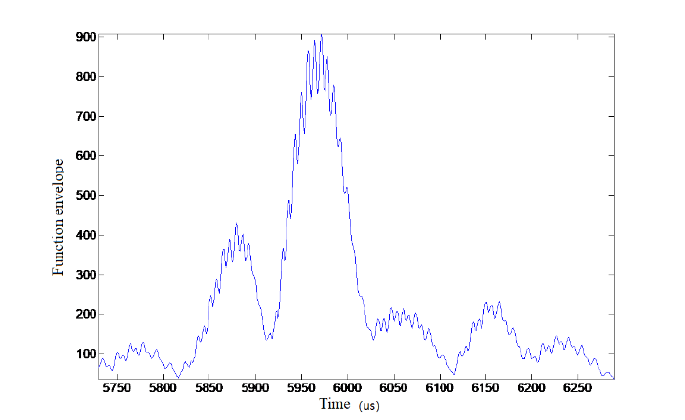
Figure 9. The correlation function envelope in test data (the main peak).